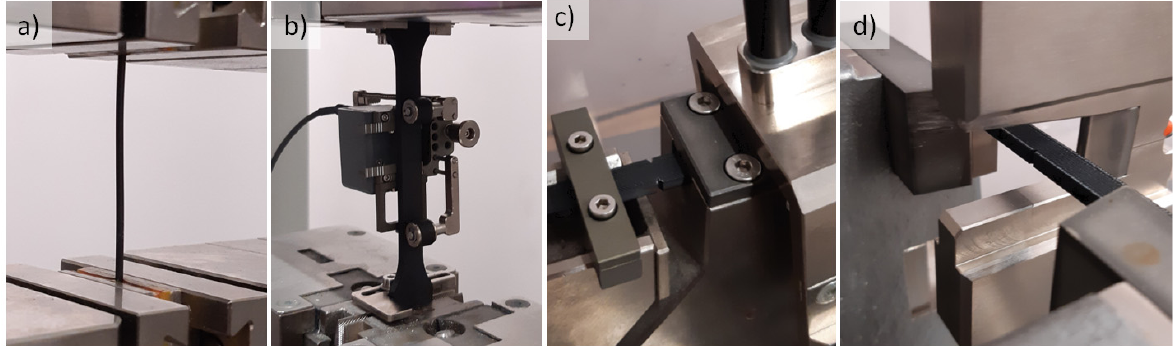
Figure 6. Research objects placed on testing stands: ( a ) filament, ( b ) dog-bone specimen, ( c ) impact tensile strength specimen, ( d ) Charpy impact test specimen.